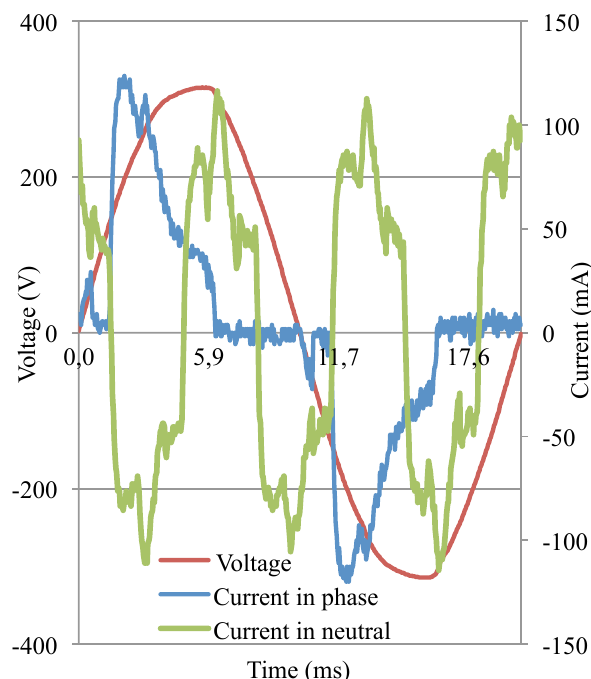
Figure 4: Voltage and current waveforms in one phase and current in the